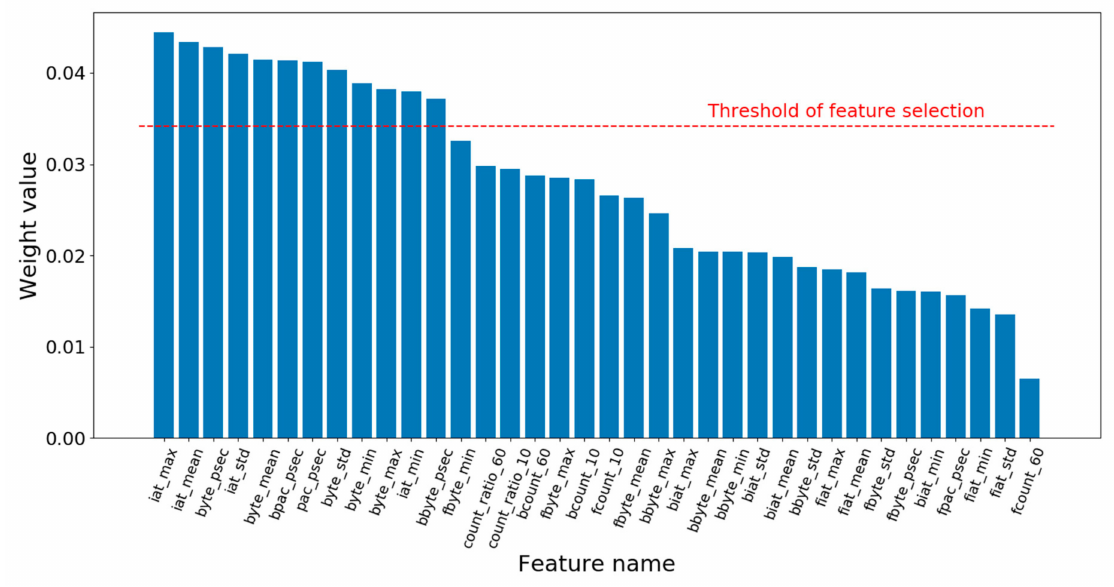
Figure 5. Accuracy of FCE-KNN for identifying encryption status of network flows with di ff erent values of nRound 1 or δ 1 :( a ): Accuracy under di ff erent nRound 1 ; ( b ) Accuracy under di ff erent δ 1 .